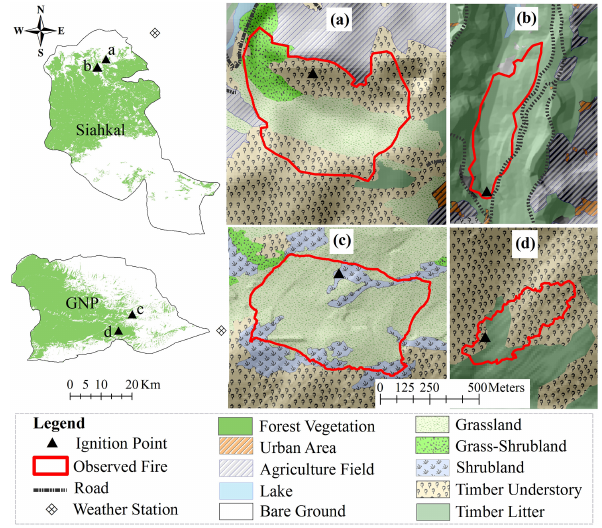
Figure 5. Fuel type maps of the sites where the selected fire events occurred: (a) Toshi and (b) Malekroud in Siahkal forest area; (c) YekeBermagh and (d) Gharangi in GNP. The nearest weather stations to the fire events are presented on the